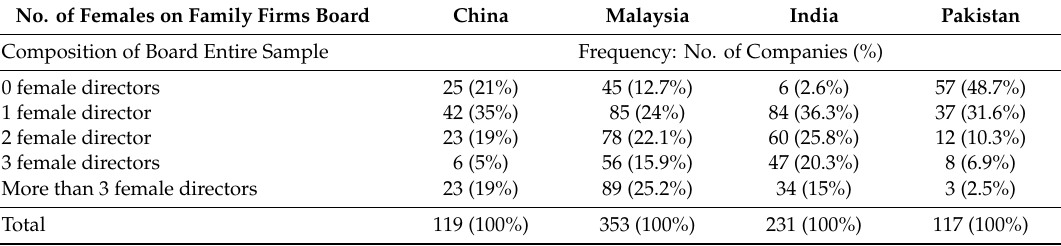
Table 3. Presence of female directors on family firms of Asian emerging economies (in the years